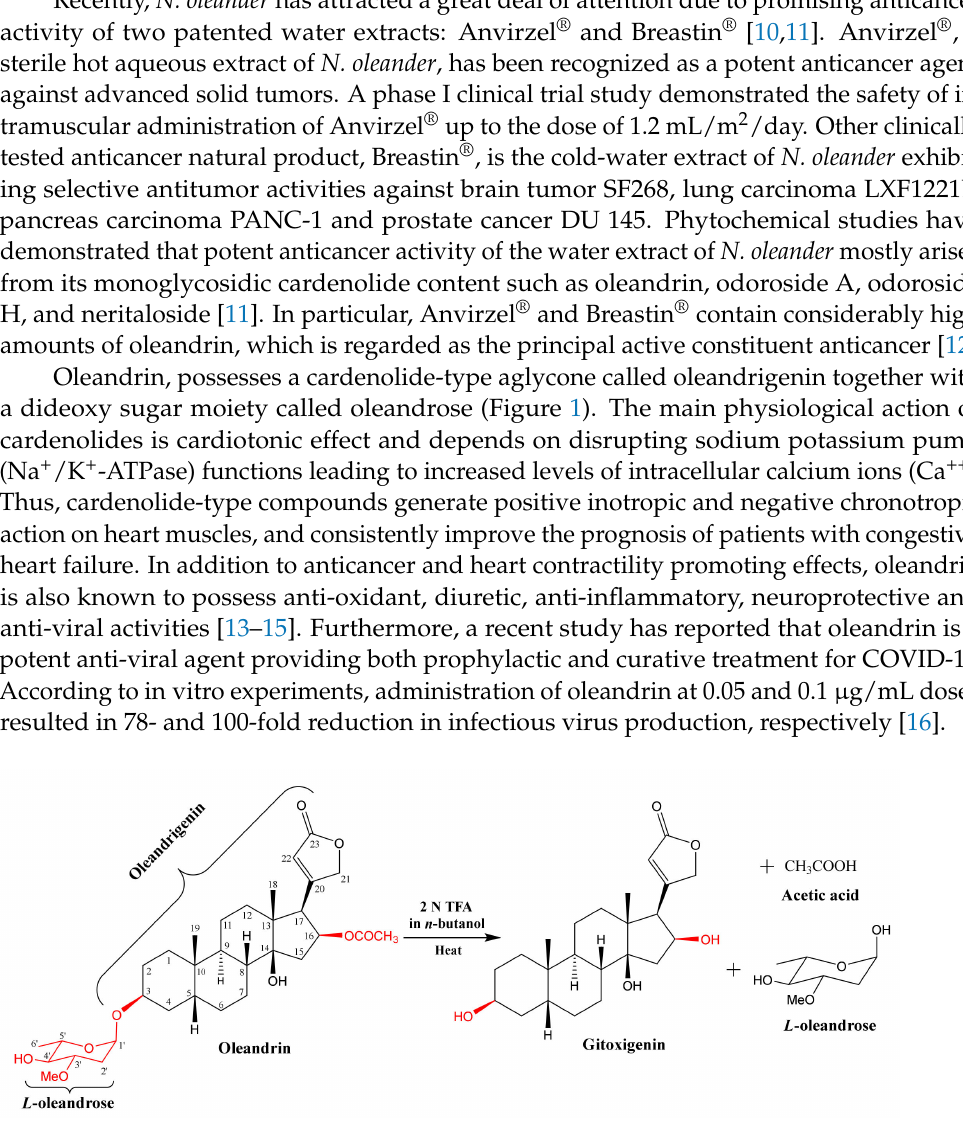
Figure 1. Acid-catalysed hydrolysis of cardiac glycoside oleandrin and structures of oleandrin, gitoxigenin and L -oleandrose (TFA: trifluoroacetic acid). Gitoxigenin is desacetyl congener of oleandrigenin (Figure 1), of which the